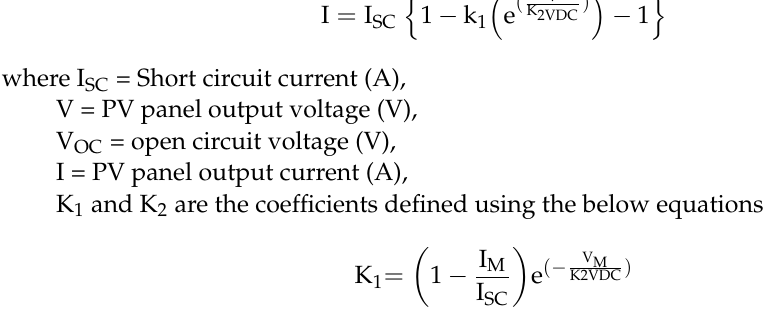
Figure 10. Power flow from PV to Grid.